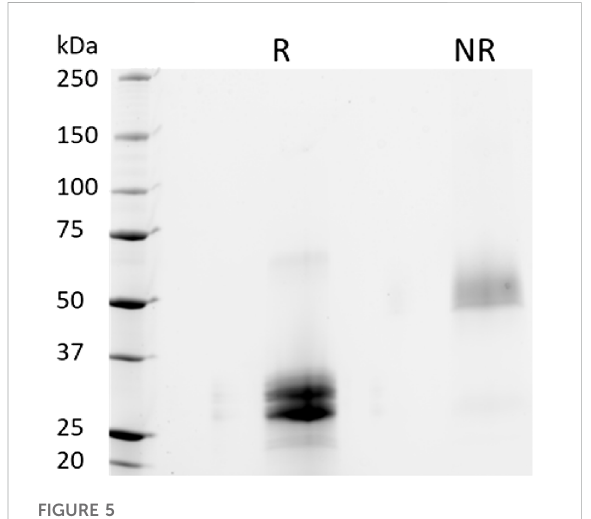
FIGURE 5 SDS-PAGE analyses of puri fi ed PTH-Fc under reducing (R) and non-reducing (NR)